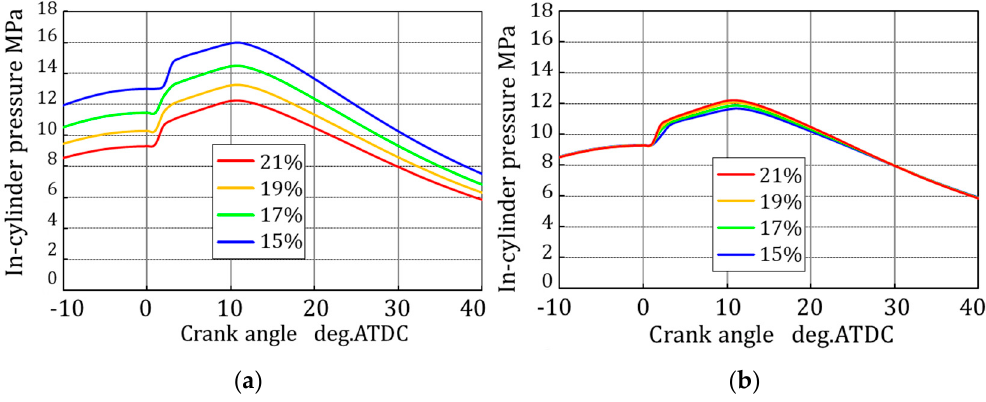
Figure 15. In-cylinder pressure versus crank angle for different EGR cases ( a ) CAS ( b ) COC. Figure 16 illustrates the heat release rate versus crank angle for EGR and WFE cases.